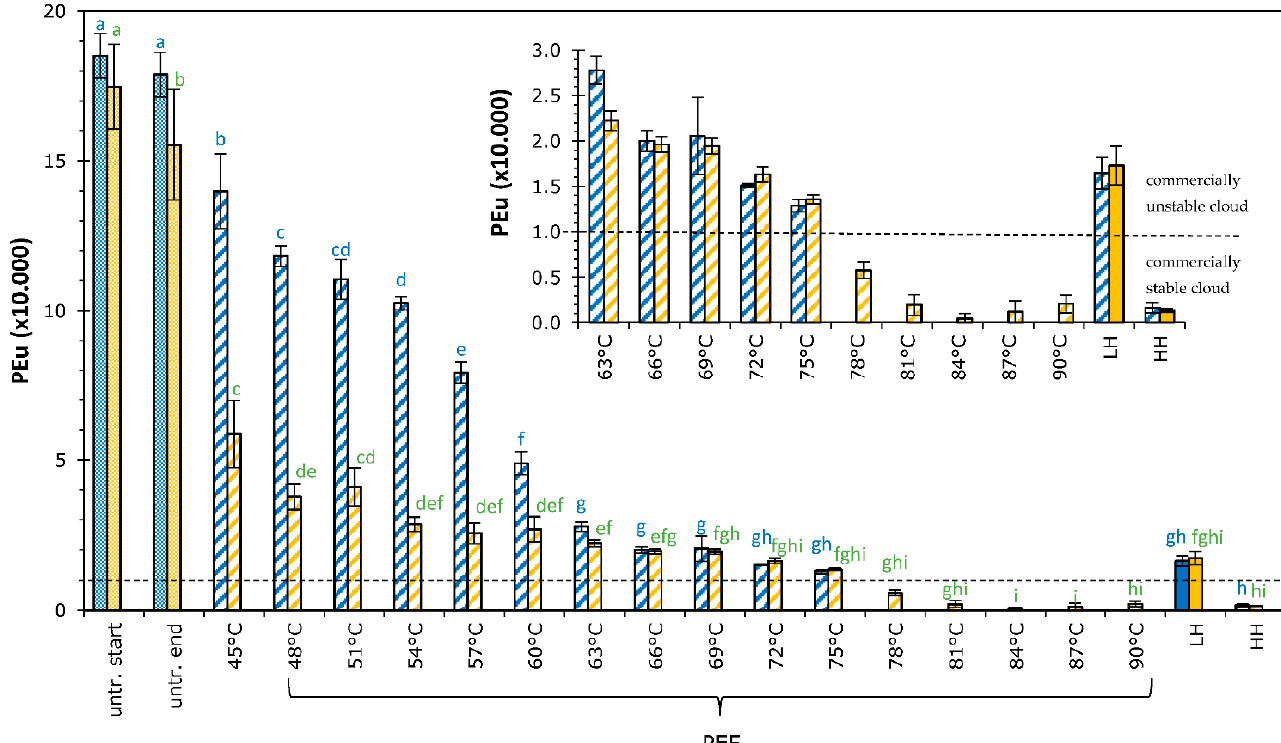
Figure 4. Effect of PEF and thermal processing on remaining pectinmethylesterase activity, expressed as pectinesterase units (PEu) in orange juice. Blue bars represent juice A, orange bars represent juice B. Values of untreated juice at start and end of the day are given. Results of various moderate intensity PEF treatment are given according to the maximum temperatures applied, using an E = 2.7 kV/cm (blue bars) and 0.9 kV/cm (orange bars). Thermal treatments are indicated as LH for low heat treatment (75 ◦ C–20 s) and HH for high heat treatment (95 ◦ C–20 s). Bars represent the average of three measurements with standard deviation. Statistical differences between the treatments are indicated with a letter per juice (color), with matching letters showing no significant difference. Juice cloud is considered commercially stable when PEu values are below 1.0 × 10 − 4 (indicated with dashed